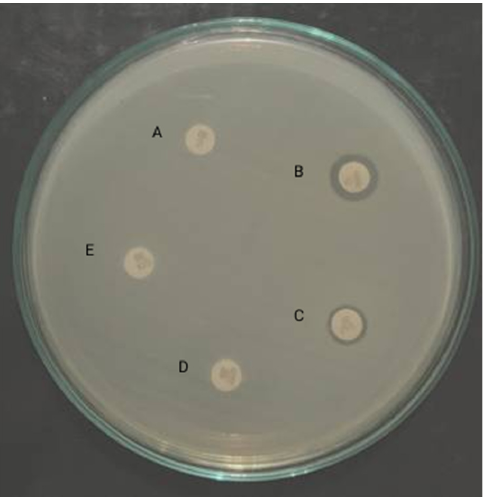
Figure 2. Antibiotic susceptibility pattern for E. coli ( A ): Gentamycin; ( B ): Ceftazidime; ( C ): Figure 2. Cotrimoxazole; ( D ): Cefotaxime; ( E ): Chloramphenicol (Resistant to all antibiotics).